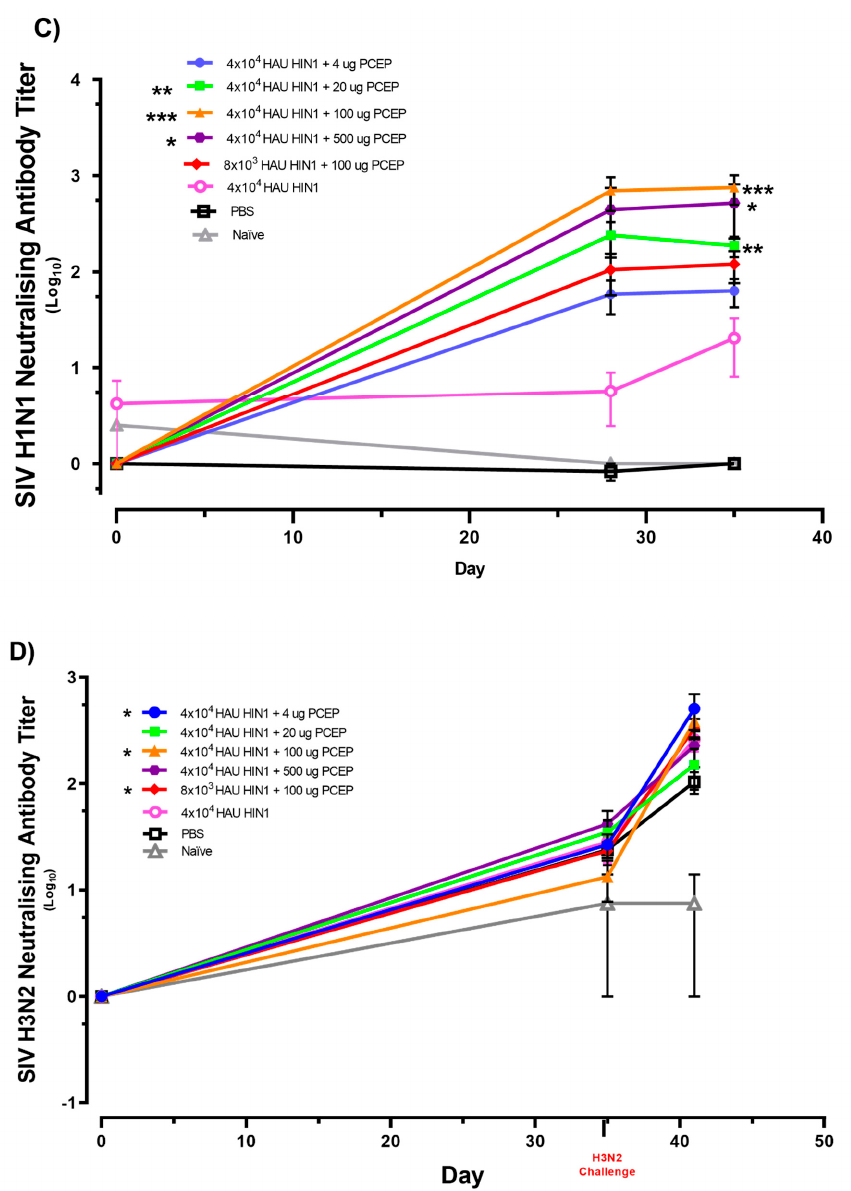
Figure 3. Swine influenza H1N1 and H3N2 ELISA and neutralizing antibody responses in pigs. Pigs ( n = 6) were immunized then boosted at day 21 via intradermal routes with 4 × 10 4 or 8 × 10 3 HAU H1N1 either alone or with varying doses (4, 20, 100 or 500 μ g) of PCEP adjuvant as indicated. Control groups were injected with either PBS or were unimmunized (naïve). They were challenged with 8 × 10 5 PFU virulent H3N2 SIV via the intratracheal route on day 35 and killed 6 days after challenge. Serum antibody titres for SIV H1N1 ( A ) and H3N2 ( B ) were assayed by ELISA over time. Red font is used for the day of challenge for emphasis. Serum SIV H1N1 ( C ) and H3N2 ( D ) neutralizing antibody titres were assessed up to day 41. Data for animal groups are presented with mean values indicated by a horizontal bar and standard error of the mean are shown. p < 0.05 (*), p < 0.01 (**) and p < 0.001